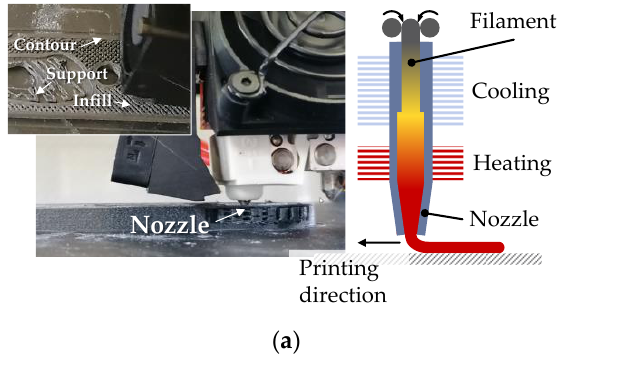
Figure 1. FLM printing: ( a ) Photo of short 15 wt.% carbon-fibre reinforced PETG-CF15 getting printed on a Raise3D Pro2 Plus ( left ) and corresponding schematic of FLM hot-end ( right ); ( b ) Illustration of various current FLM material modeling approaches as described in the text.